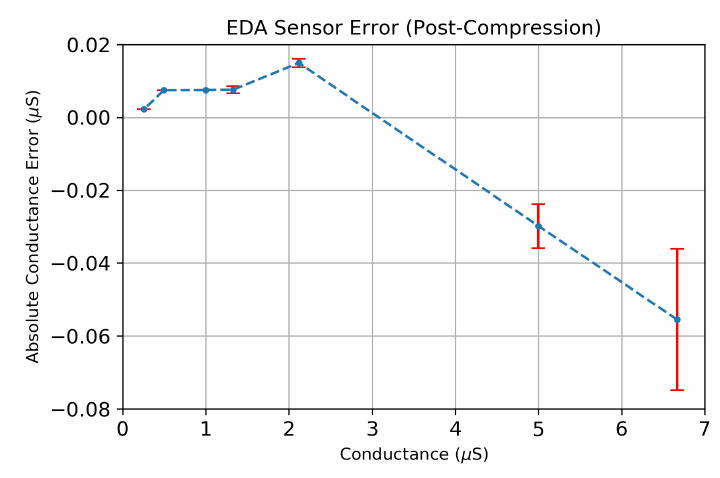
Figure 12. The absolute error of the EDA sensor across a range of conductance values using the compression ratio (CR = 17.1 × ). Each error measurement consists of 100 measurements of a known, fixed resistor having a conductance equal to G = 1/ R .